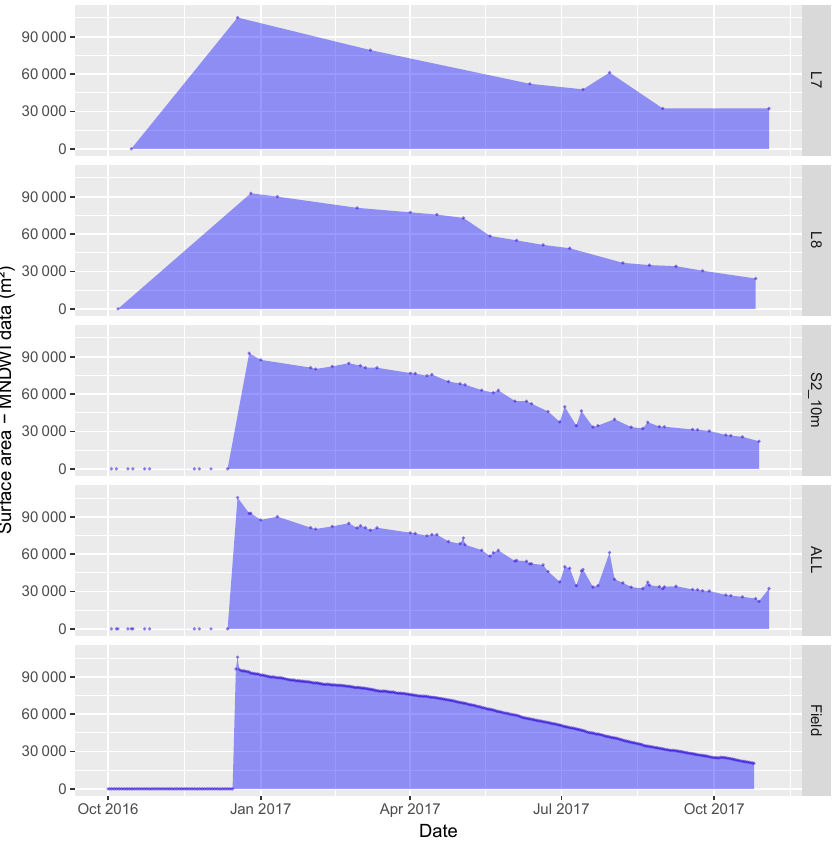
Figure 21. Surface water extent dynamics from Sentinel-2 and Landsat 7 and 8 and field data over 2016–2017 on lake